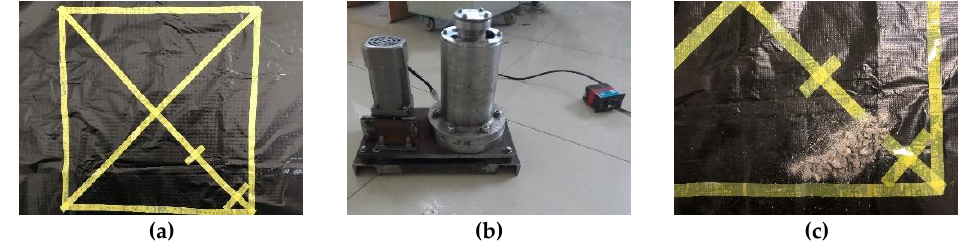
Figure 10. The equipment and results of the experiment. ( a ) The circumferential coordinates systems of the working plane. ( b ) The reduced-scale experimental cone crusher and inverter. ( c ) The broken particles on the working plane. Table 1. The structural and operating parameters of reduced-scale experimental cone crusher.